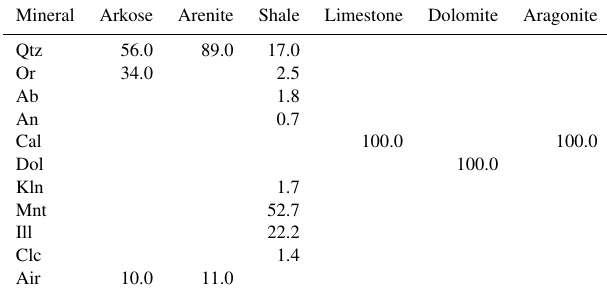
Table A1. Volumetric percentages of the rock-forming minerals within six sedimentary rocks. Qtz: quartz, Or: orthoclase, Ab: al- bite, An: anorthite, Cal: calcite, Dol: dolomite, Kln: kaolinite, Mnt: montmorillonite, Ill: illite, Clc: clinochlore.